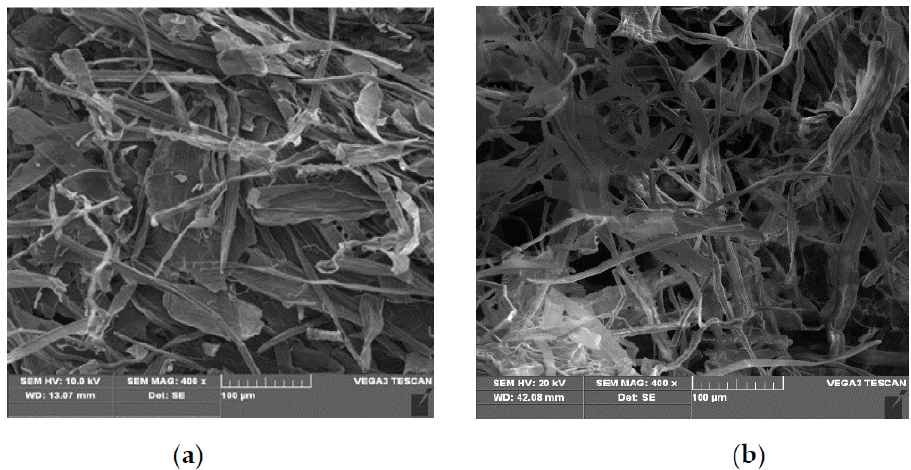
Figure 1. SEM images of cellulose fibers before ( a ) and after ( b ) ultrasonic irradiation.